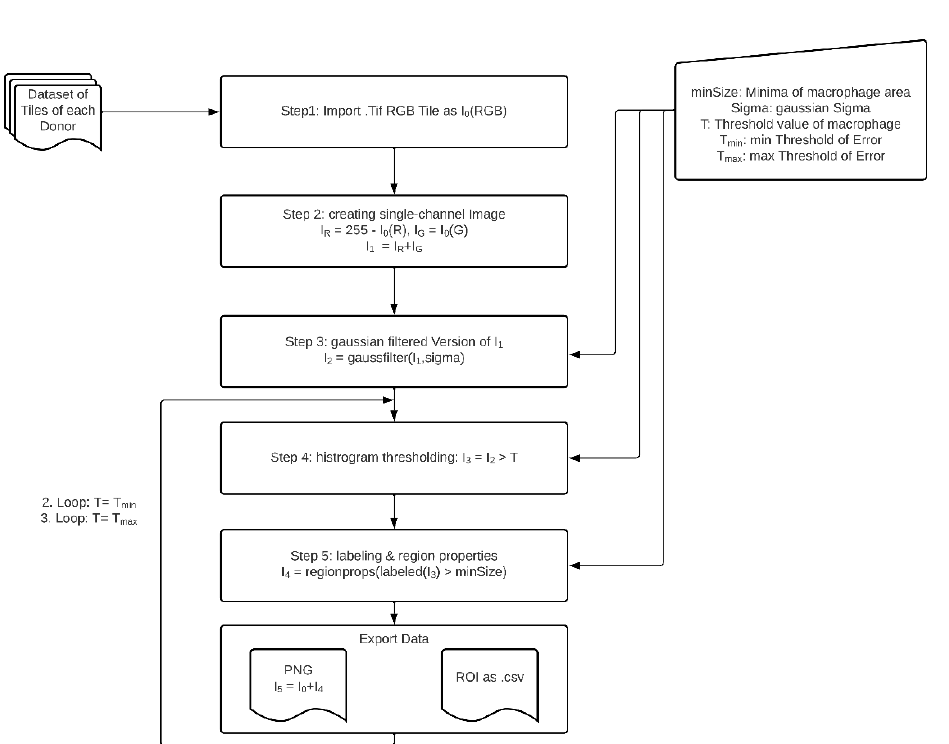
Figure 1. Flowchart of macrophage segmentation method. Human liver tissue samples were stained with HRP-conjugated antibodies against macrophages and visualization was done using DAB. Images were taken of whole tissue sections and further processed in several steps to finally identify, label, and analyze the regions corresponding to stained macrophages.